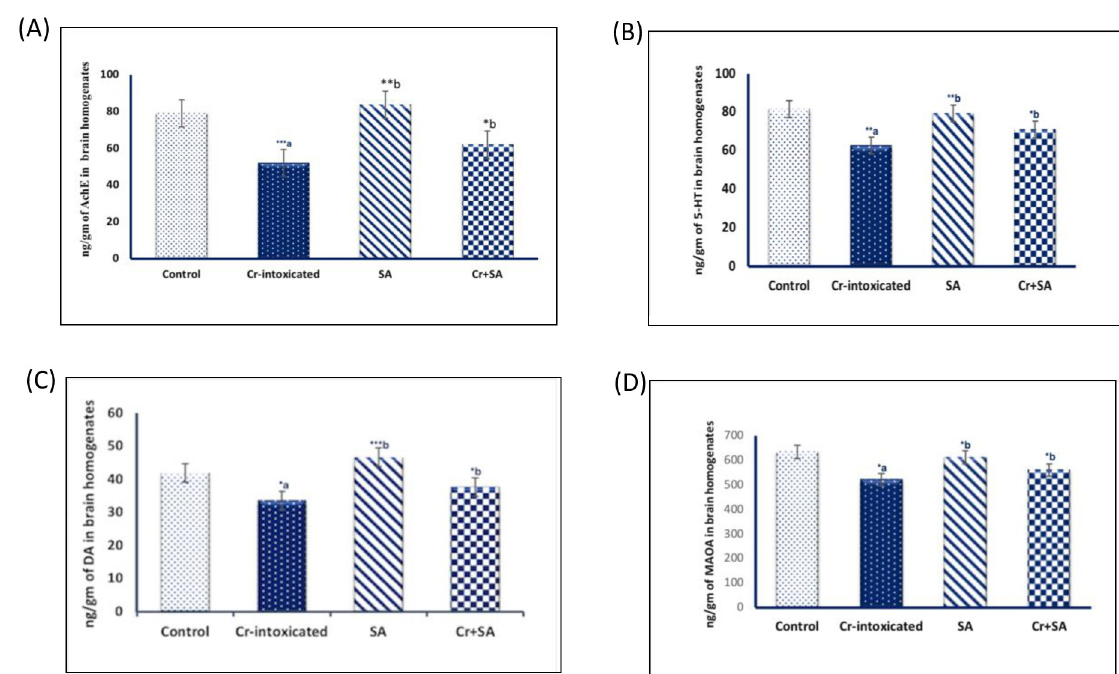
Fig 2. Effects of Cr and SA on (A) Acetyl choline esterase, (B) 5-Hydroxytryptamine, (C) Dopamine, (D) Monoamine oxidase. Values are expressed as mean ± SE (n = 10). � a p � 0.05 compared with control group, �� a p � 0.005 compared to control group and ��� a p � 0.001 compared to control group. � b p � 0.05 compared with Cr group, �� b p � 0.005 compared to Cr group and ��� b p � 0.001 compared to Cr group.